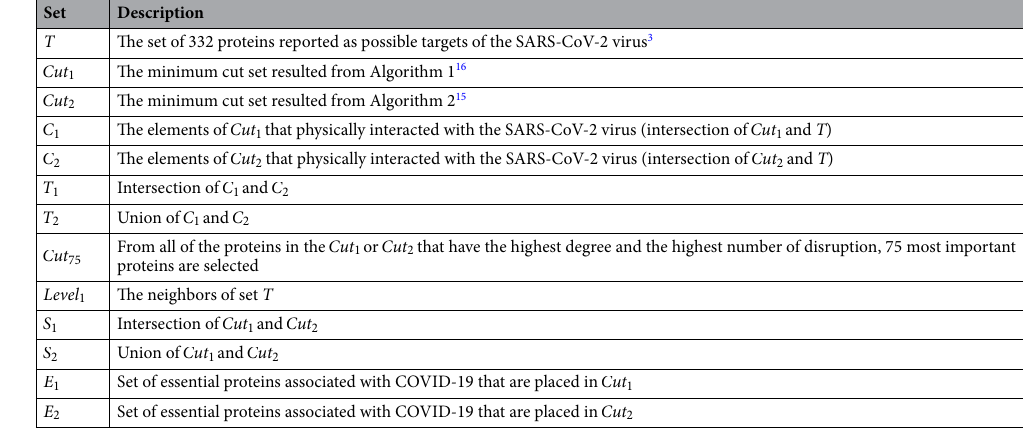
Table 1. Description of the defined sets. Best results are indicated in bold.